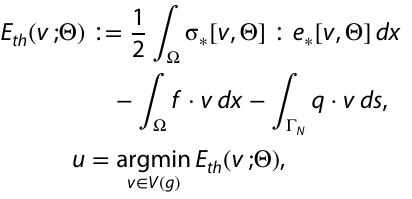
Fig. 11 Mode III crack growth under the given boundary displace- ment g = ∓ t ( 0,0,6 ) on Γ ± D